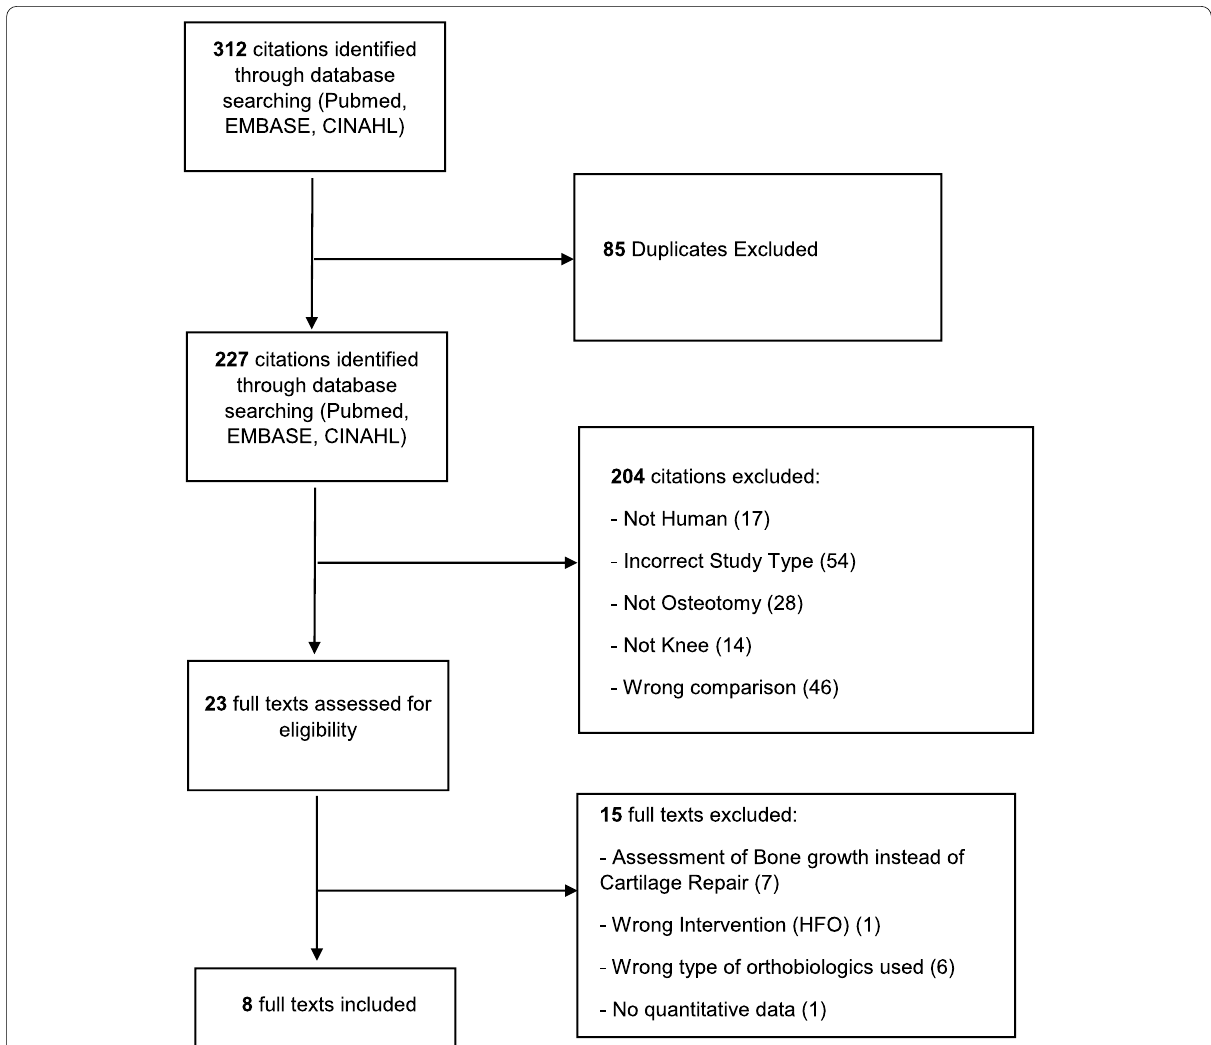
Fig. 1 PRISMA Flowchart. The search workflow was performed in accordance to the Preferred Reporting Items for Systematic Reviews and Meta-Analyses